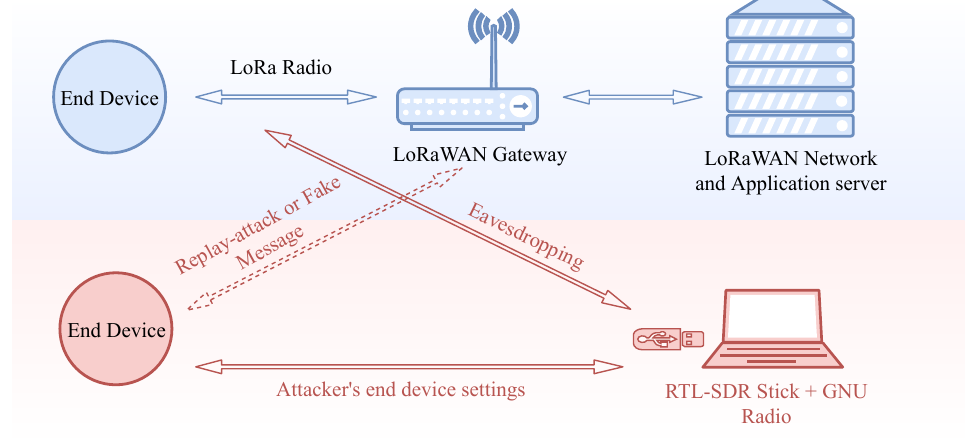
Figure 4. LoRaWAN security test bed structural